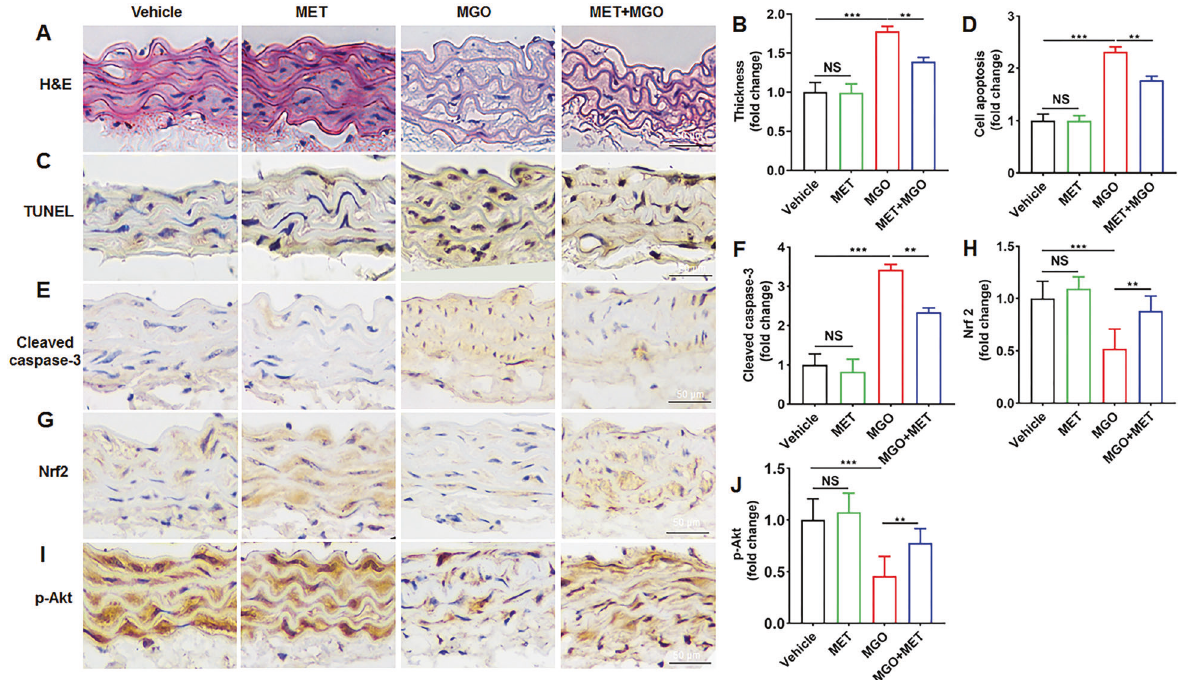
Fig. 6 MET prevents MGO-induced apoptosis by modulating the PI3K/Akt and Nrf2/HO-1 pathways in vivo. C57BL/6 mice were treated with MGO and MET, after which the aortas were collected for biochemical parameters. A , B Histological changes in the aortas were evaluated by H&E staining. C , D Apoptosis was evaluated by TUNEL staining. E , F The proapoptotic factor cleaved caspase-3 was evaluated by Immunohistochemistry staining. G , H Nrf2 expression was evaluated by Immunohistochemistry staining. I , J The phosphorylation of Akt was also determined by